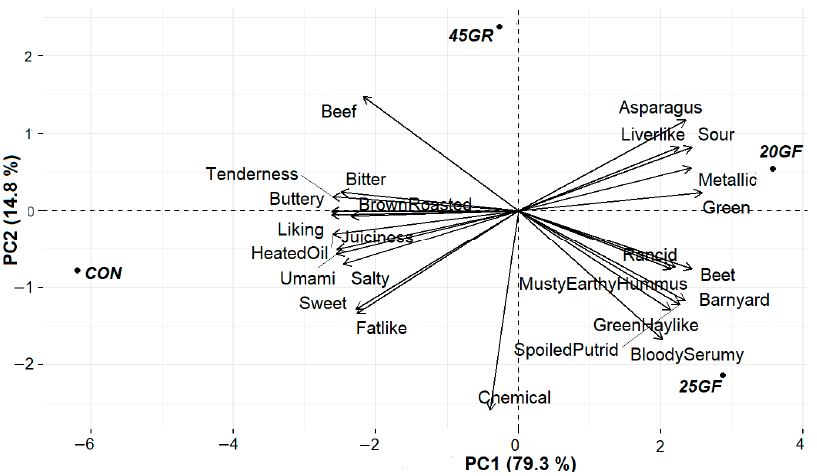
Figure 3. Principal Component Analysis (PCA) relating the flavor profile and consumer panel score of steaks from conventional grain finished beef (CON, n = 12), 20–months–grass–fed beef (20GF, n = 12), 20–months–grass–fed + 45–day–grain–finished beef (45GR, n = 9), and 25–months–grass–fed beef (25GF, n =